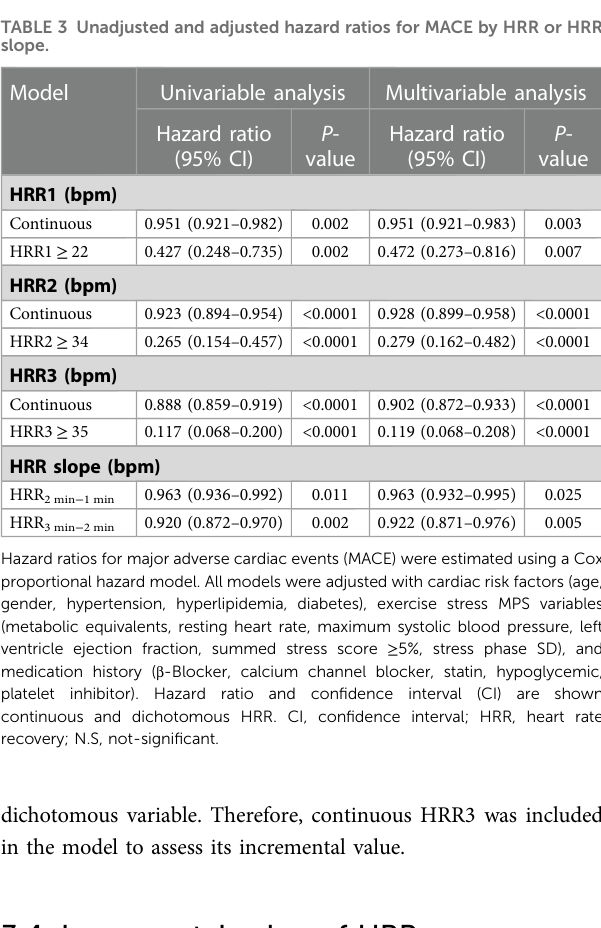
The global χ 2 fi ndings for the MACE prediction are shown in Figure 4 . Compared to model 1 (clinical data alone, P = 0.009), the global χ 2 for model 2 (clinical data plus SSS) dramatically increased. Additionally, global χ 2 for the models that included clinal data, SSS, and HRR variables (model 3: clinal data + SSS + HRR1, model 4: clinal data + SSS + HRR2, model 5: clinal data + SSS + HRR3) were signi fi cantly higher than those for model